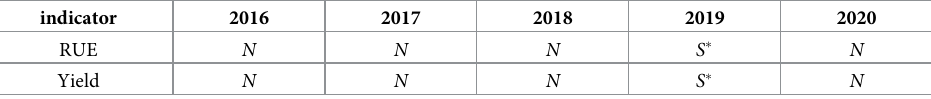
Table 6. Effect of straw and tillage interaction on RUE and yield in different year corresponding to rainfall precip- itation pattern. indicator RUE N N N S � N Yield N N N S � N Note: N indicates no significant effect ( P > 0.05, double tail); S � indicates significant effect ( P < 0.05, double tailed